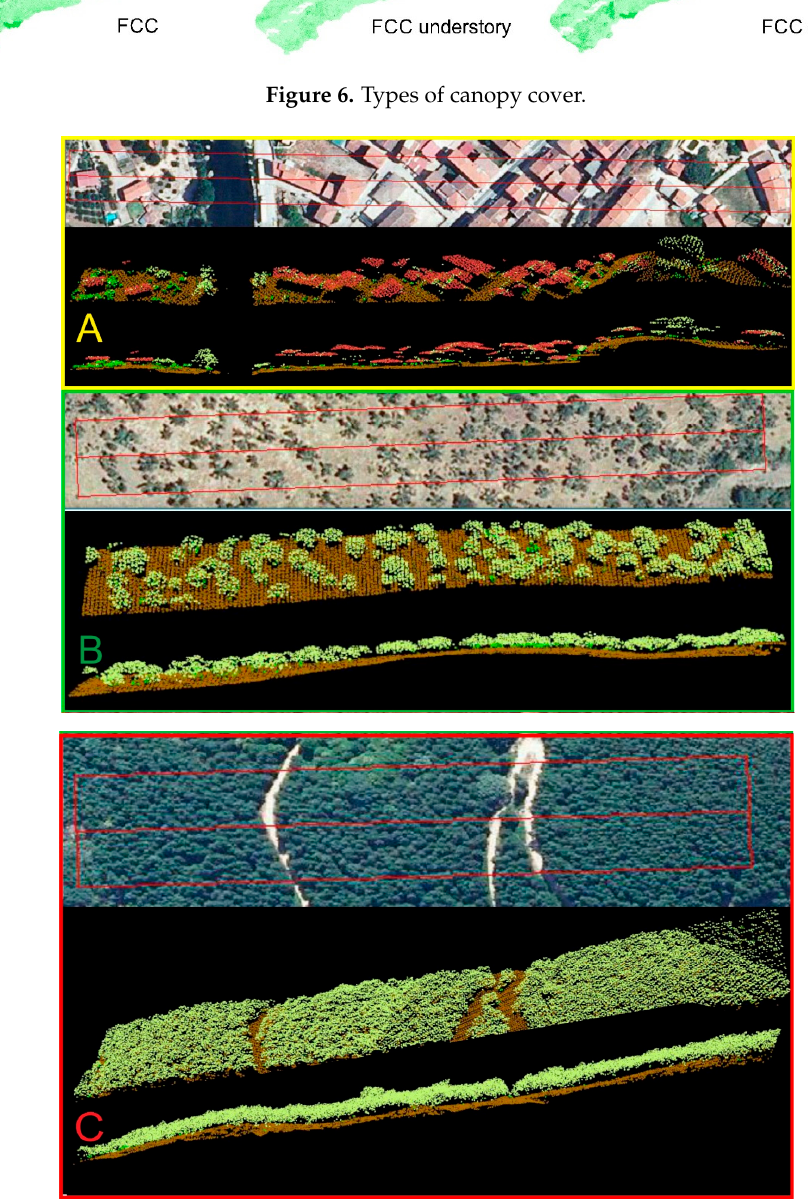
Figure 6. Types of canopy cover.